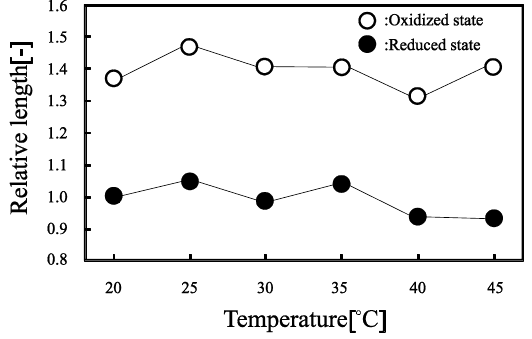
Figure 10. Equilibrium swelling ratios of poly(VP-co-Ru(bpy) temperature in solutions with (●) [Ce (○) [Ce(SO ) ] = 0.001 M and [HNO 4 2 of the characteristic diameter to that at the initial state at 20 °C. (Reprinted from [45], Copyright American Chemical Society. Reproduced with permission.)